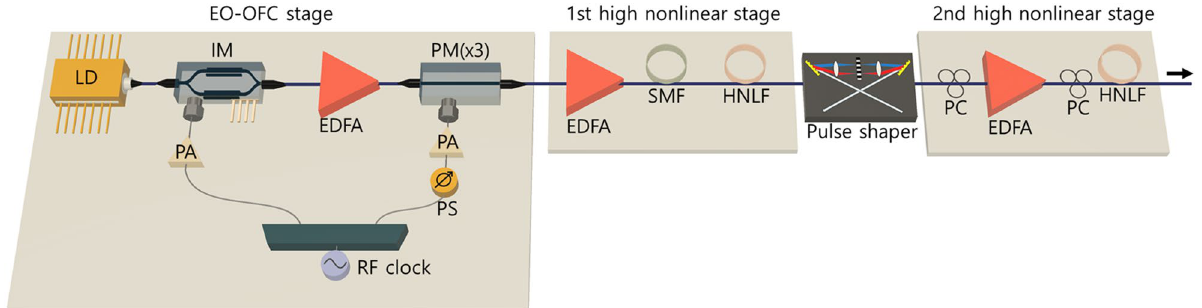
Figure 1. Schematic diagram of ultra-broadband flat-topped supercontinuum generator. IM optical intensity modulator, PM optical phase modulator, EDFA Erbium-doped fiber amplifier, PA power amplifier, PS phase shifter, EDFA Erbium-doped fiber amplifier, SMF single-mode fiber, HNLF highly nonlinear fiber, PC polarization